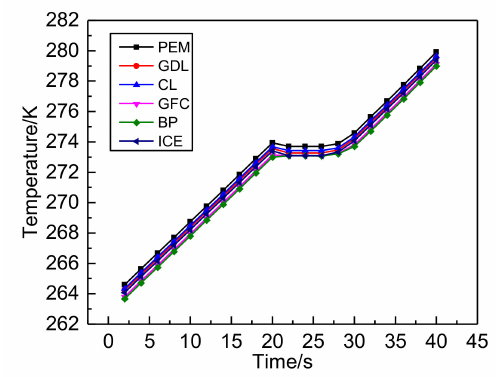
Figure 6. The average temperature distribution of each layer in the PEMFC